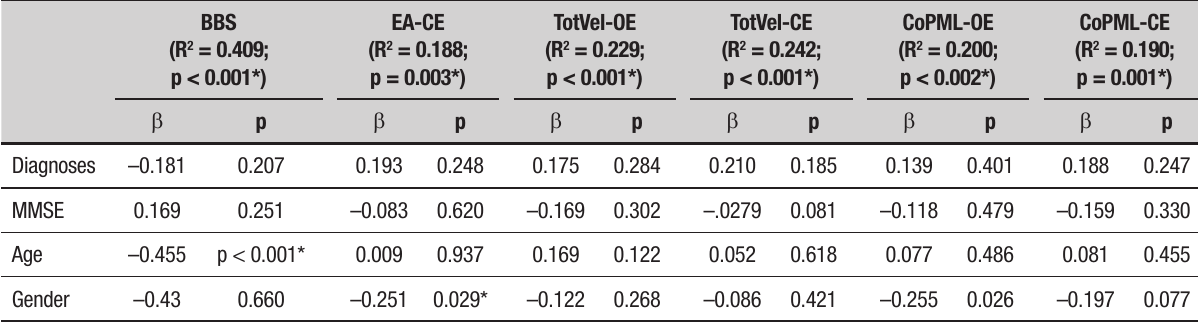
Table 4. Linear regression for the stabilometry measurements (WBB) and balance (BBS) controlled for independent